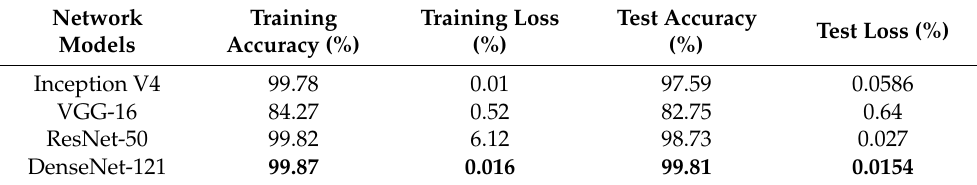
Figure 8. Recognition accuracy of DenseNet-121. ( a ) Training and testing accuracy; ( b ) training and validation loss in DenseNet-121 using PlantVillage dataset. Table 5. Comparative performance analysis of various network models.